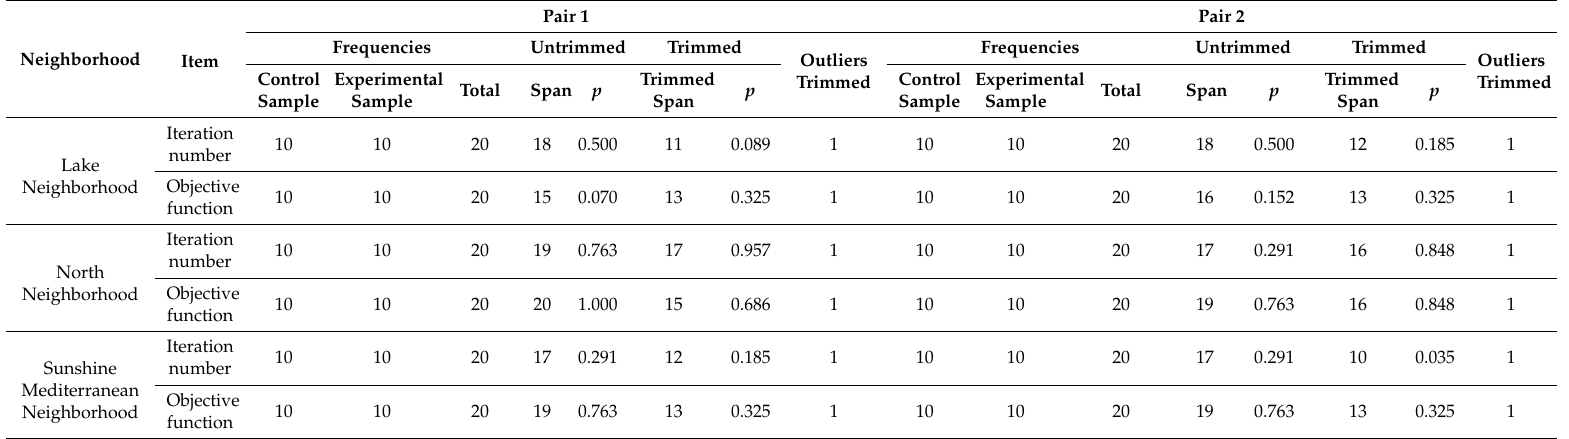
Table 3. The Moses Extreme Reactions (MER) test results of the two